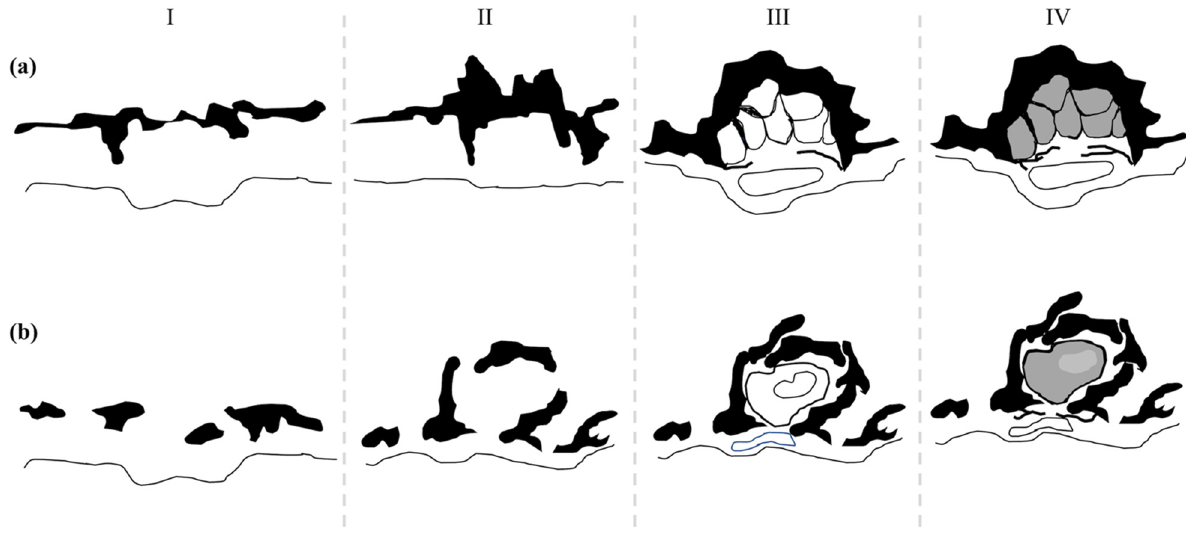
Figure 4. Schematic representation of ( a ) Etmopteridae and ( b ) Dalatiidae stereotypical photophores development steps. I: pigmented cells aggregation; II: cup-shaped pigmented cells formation; III: protophotophore (without autofluorescent vesicles), lens, and ILS cells appearance; IV: maturation of protophotophore to photophore with autofluorescent functional photocyte and bioluminescence capability acquisition.